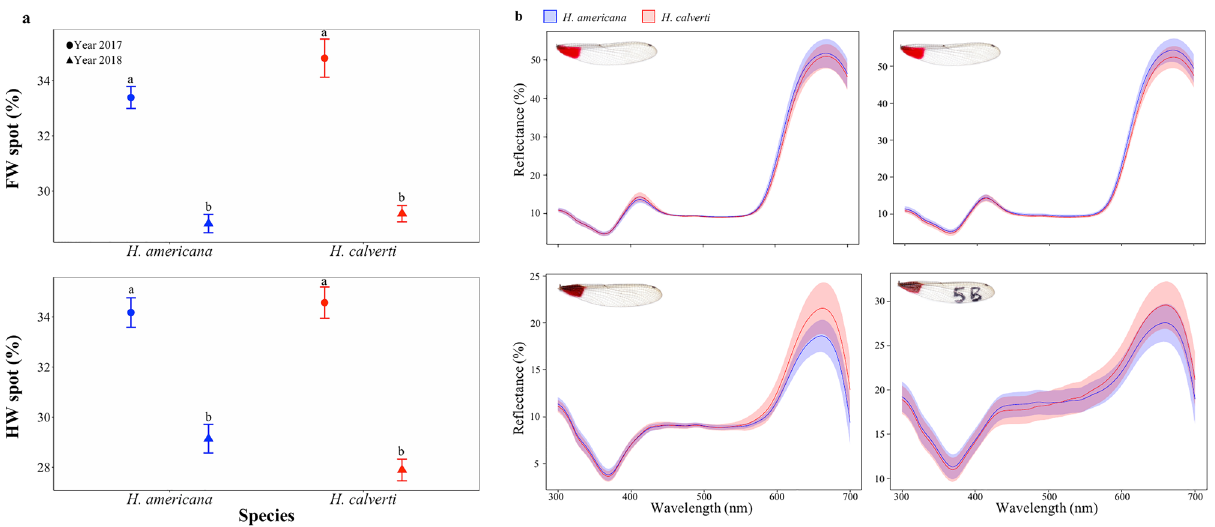
Figure 3. Variation in wing spots between species. ( a ) Variation in the percentage of FW (above) and HW (bottom) spots between species and years. ( b ) Reflectance patterns of FW (above) and HW (bottom), including inner (left) and outer (right)